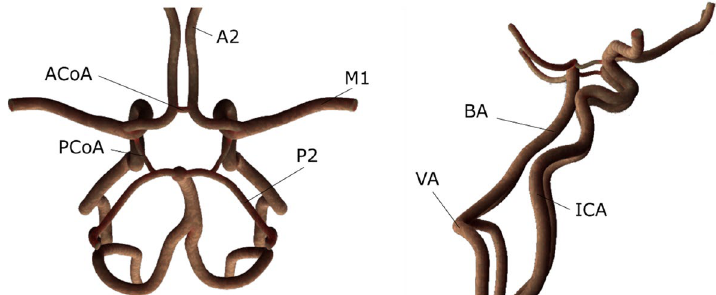
Figure 7. Two projections/views of a modeled